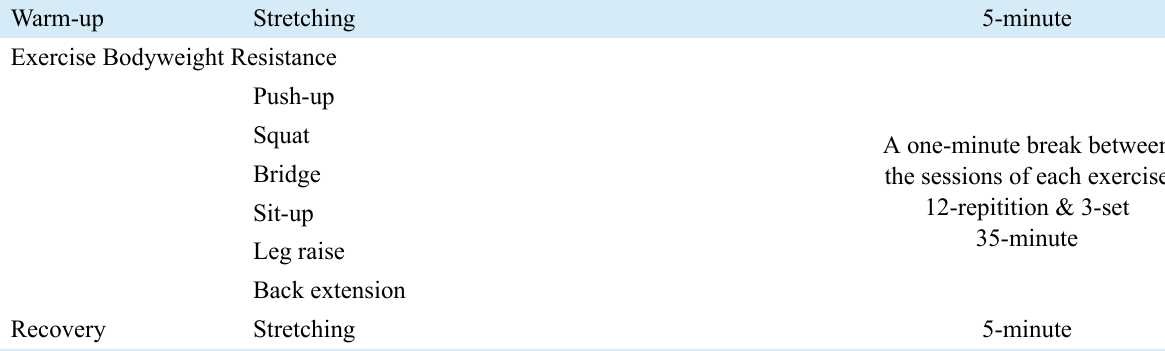
FIGURE 1. Flow chart of the study. TABLE 1. A bodyweight resistance exercise training.